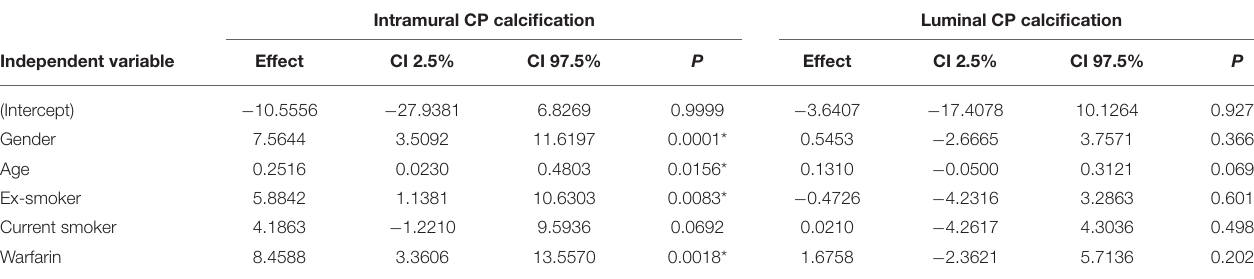
TABLE 3 | Results of the multivariable linear regression model for histological